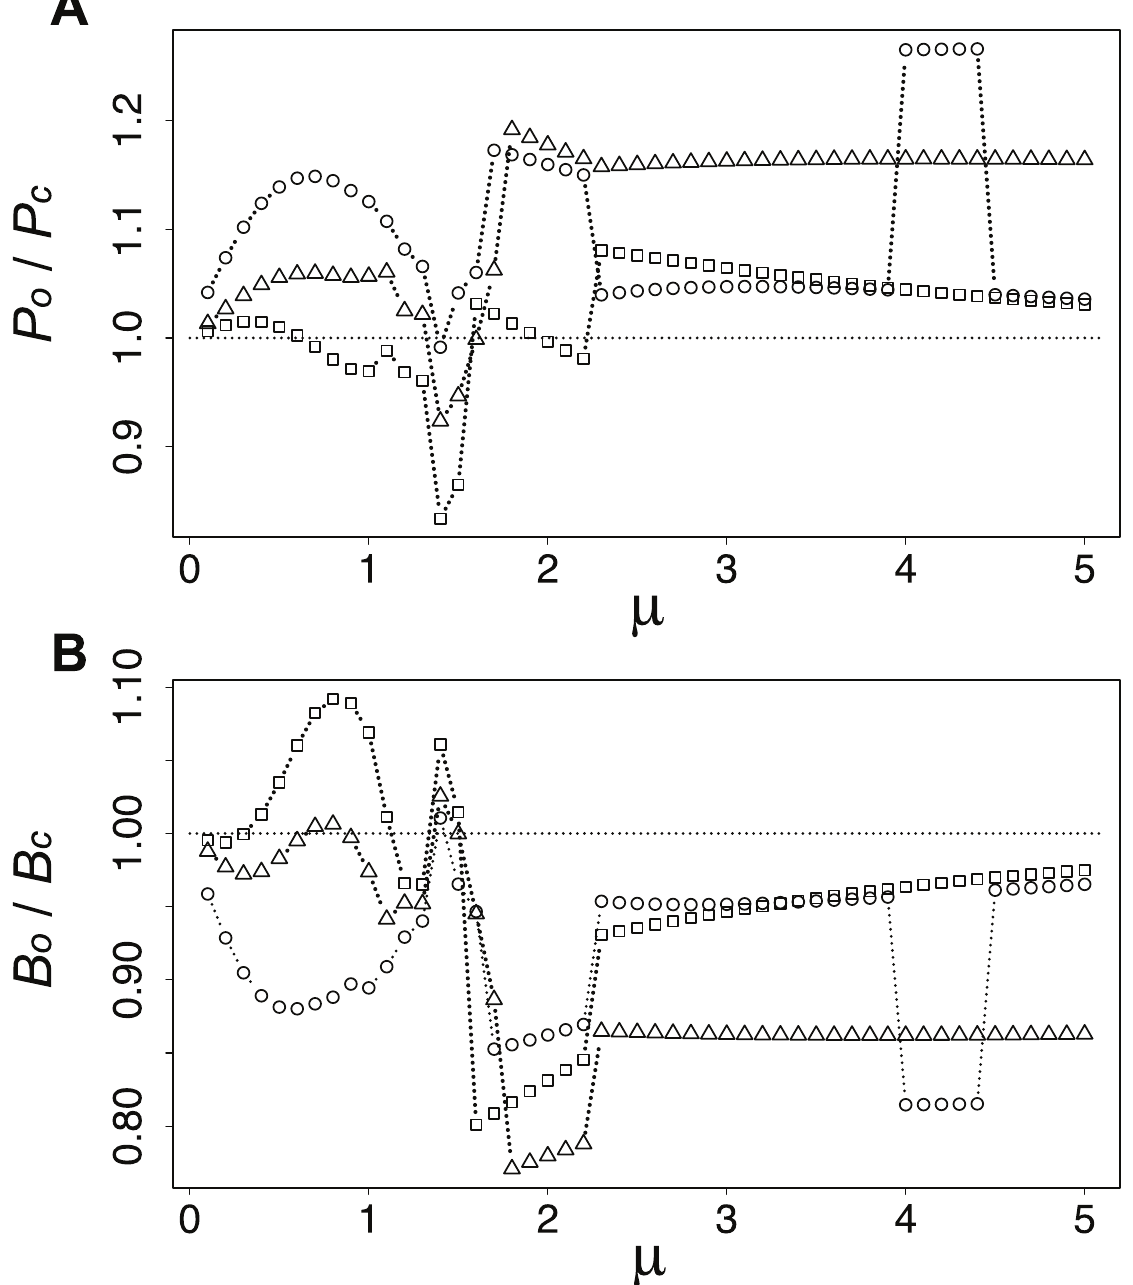
Figure 6. Comparison of the performances for the networks designed under constant and oscillatory conditions. A Ratio in loss, P o = P c . B Ratio in cost, B o = B c . Circles, triangles, and squares respectively denote ~ 0, p = 2, p . The data are those for the homogeneous initial conditions of D ij .